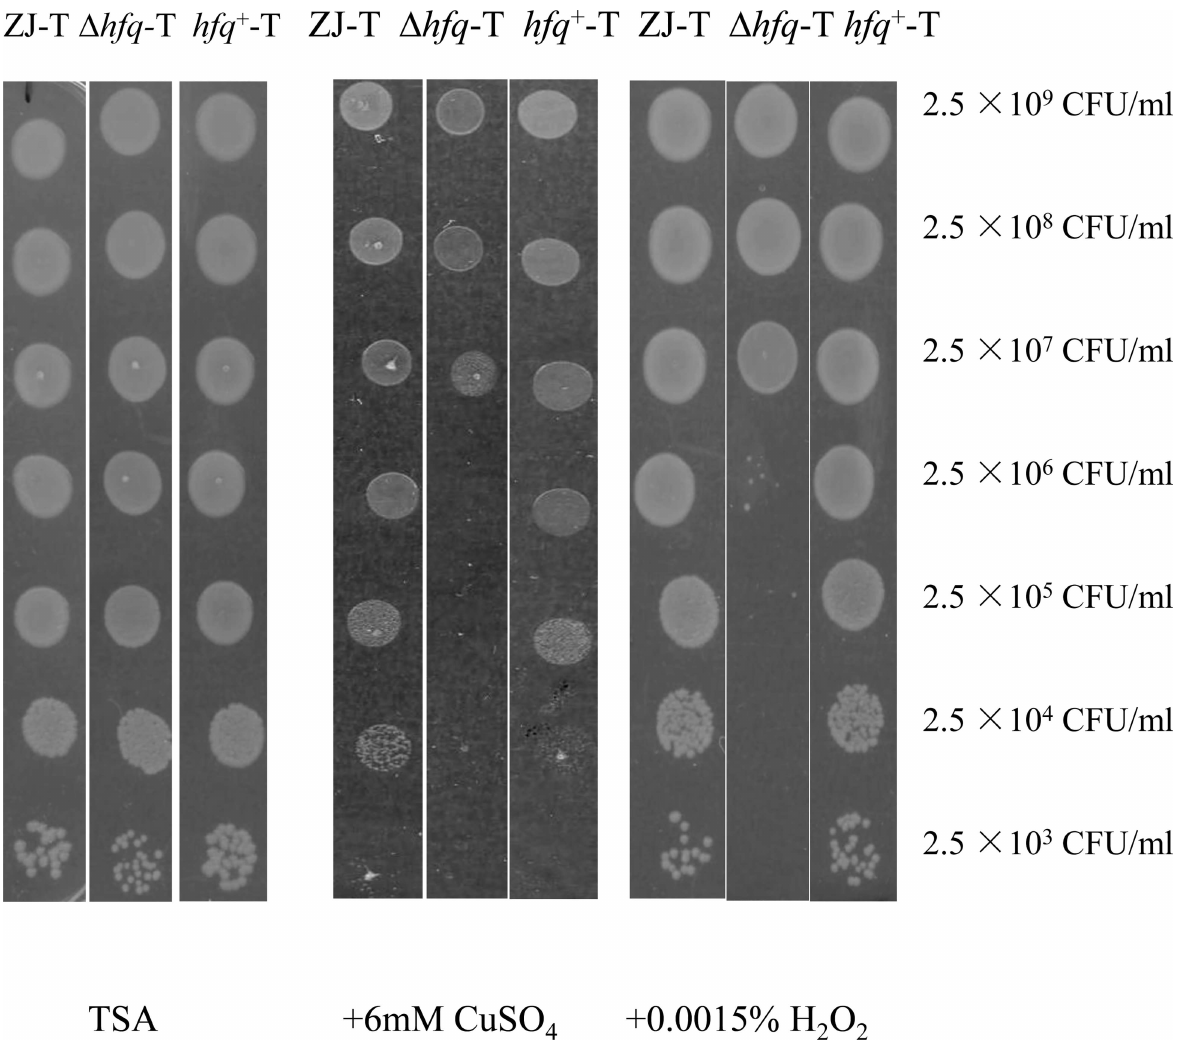
Fig 3. Δ hfq -T showed increased sensitivity to CuSO 4 and H 2 O 2 . Serial dilution of cultures of ZJ-T, Δ hfq -T and hfq +-T were spotted on TSB agar plates (left panel), in presence of 6 mM CuSO4 (middle panel) or 0.0015%H 2 O 2 (right panel). The picture is representative of the results of at least ten